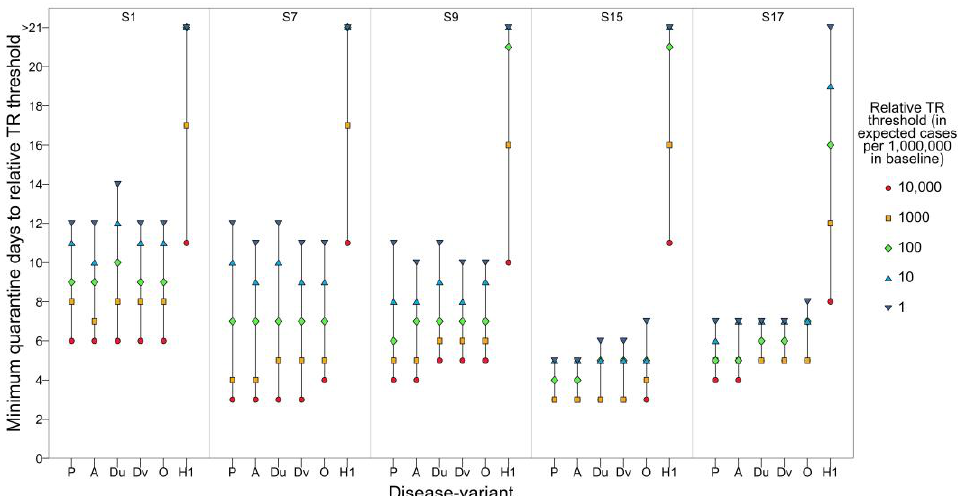
Figure 7. Minimum quarantine length to pass relative TR threshold, by strategy family (S1, S7, S9, S15, S17) and disease variant. P denotes prealpha, A denotes alpha, Du denotes delta (unvaccinated), Dv denotes delta (vaccinated), O denotes omicron (vaccinated) and H1 denotes influenza A-H1N1. When points overlap, the lowest (strictest) threshold is displayed rather than any higher thresholds, which require the same minimum quarantine length. The remaining strategies are presented in Table S2.1.